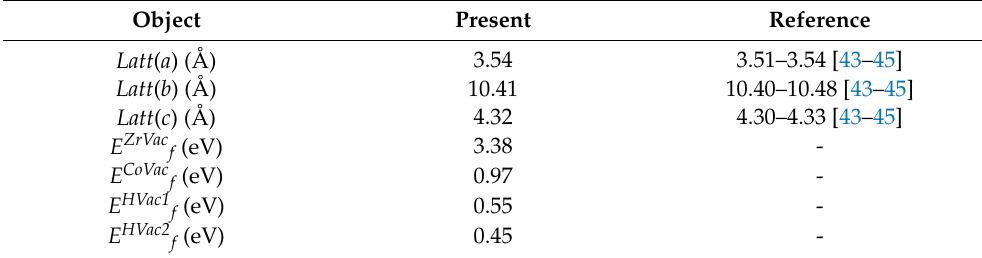
Table 1. The lattice parameters, as well as vacancy formation energies, in ZrCoH 3 . The available reference values are also listed here for